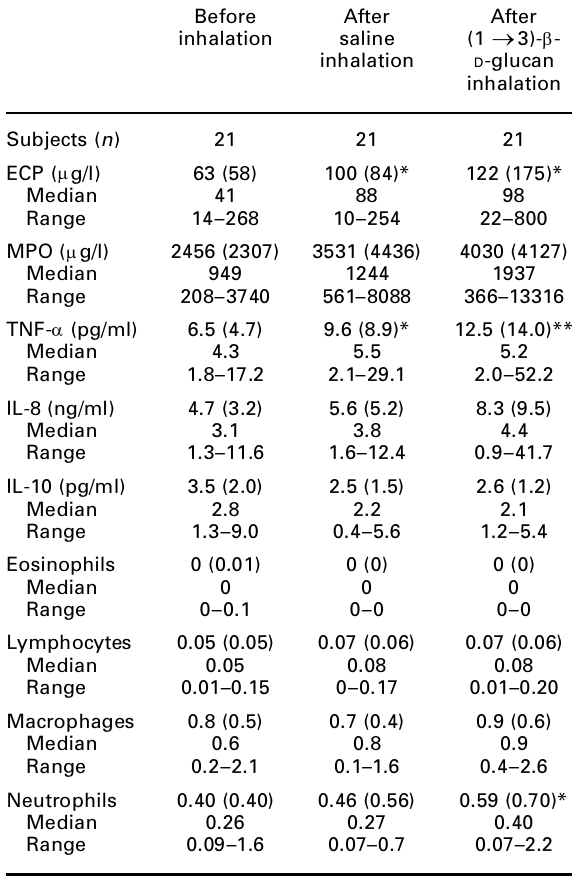
Table 1. Amounts of ECP, MPO, TNF- a , IL-8 and IL-10 as well as the number of cells ( ´ 10 9 /l) in induced